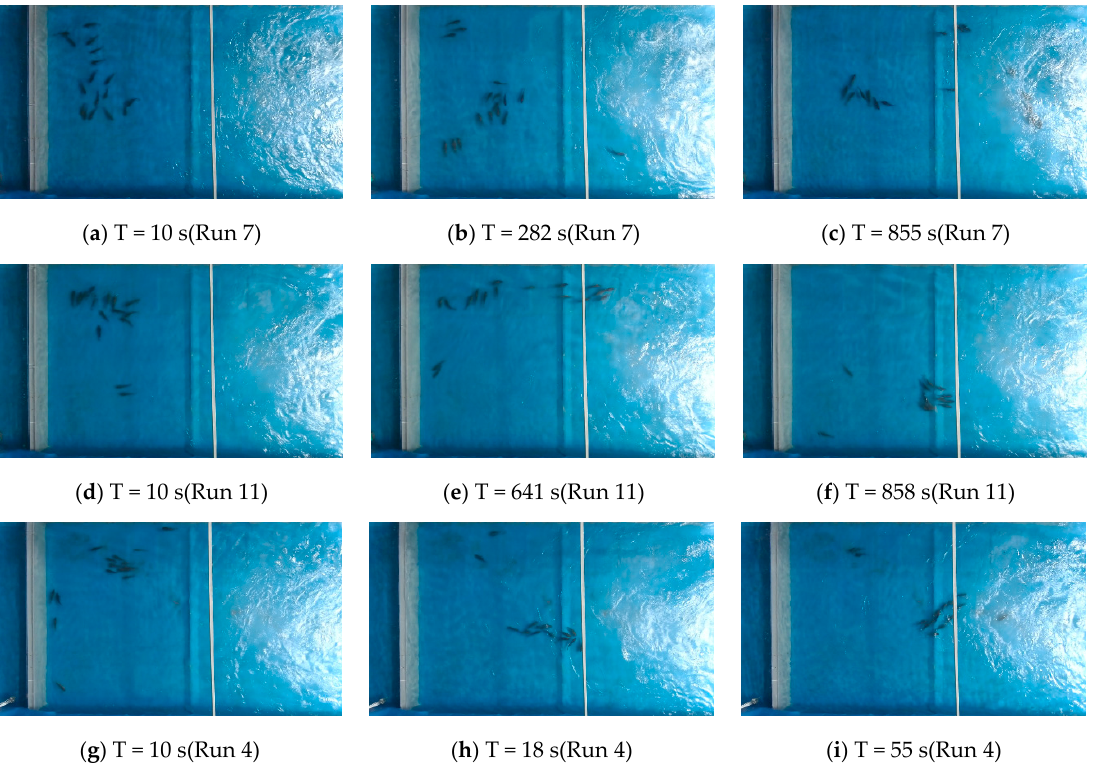
Figure 13. Distribution of experimental fish at different moments in some experimental groups un ‐ der different water flow conditions, ( a – c ) run 7—lateral symmetric bimodal outflow; ( d – f ) run 11—lateral asymmetric bimodal outflow; and ( g – i ) run 4—single ‐ peak outflow.